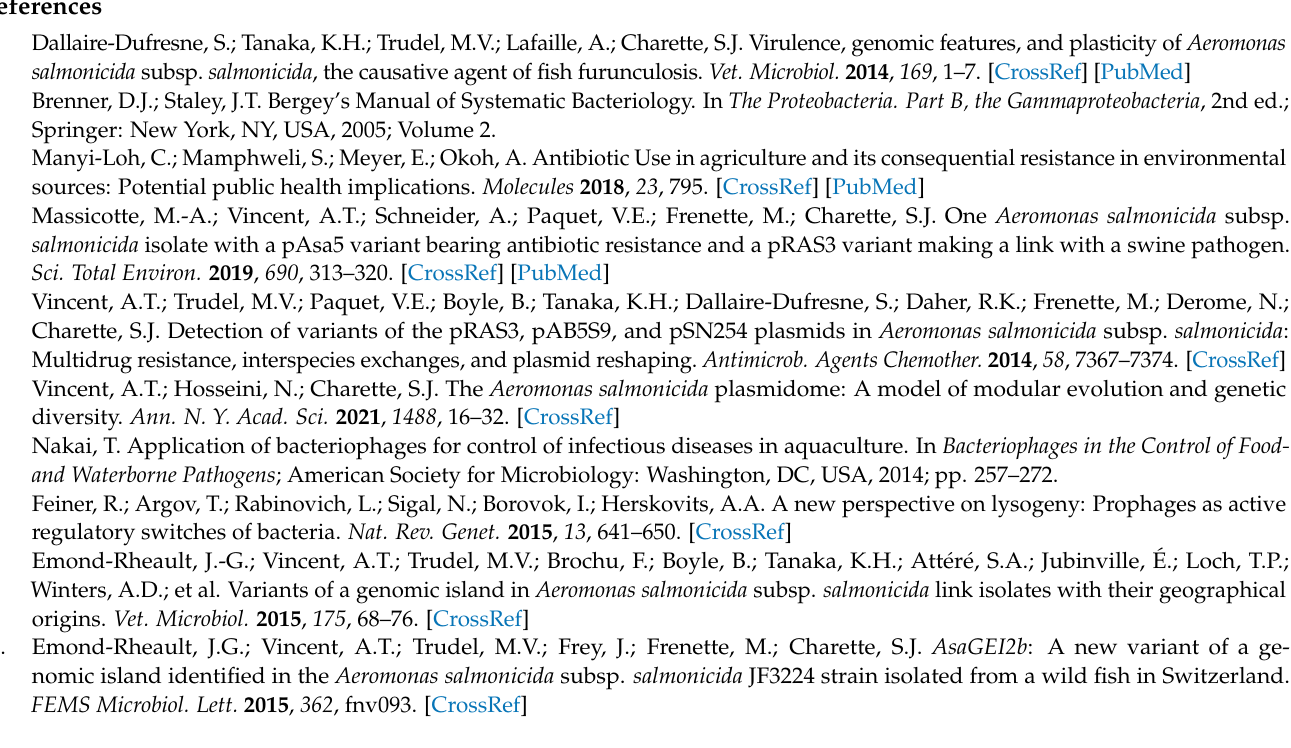
Supplementary Materials: The following are available online at https://www.mdpi.com/article/10 .3390/v13112241/s1, Table S1. Phage cocktails used in this study. Table S2. Local virulence index Table S3. Local virulence index for cocktail T against various A. salmonicida subsp. salmonicida strains with different genetic backgrounds. Table S4. Local virulence index for cocktail T against different A. salmonicida subsp. salmonicida strains with or without Prophage 3. Table S5. Sensitivity of A. salmonicida subsp. salmonicida strains harboring various genetic elements to five individual phages using the spot test assay. Figure S1. Growth curves for the European strains A449 and JF3791 in presence of the phage cocktail T (MOIs 0.1, 1 or 10) compared to the growth of the strains without